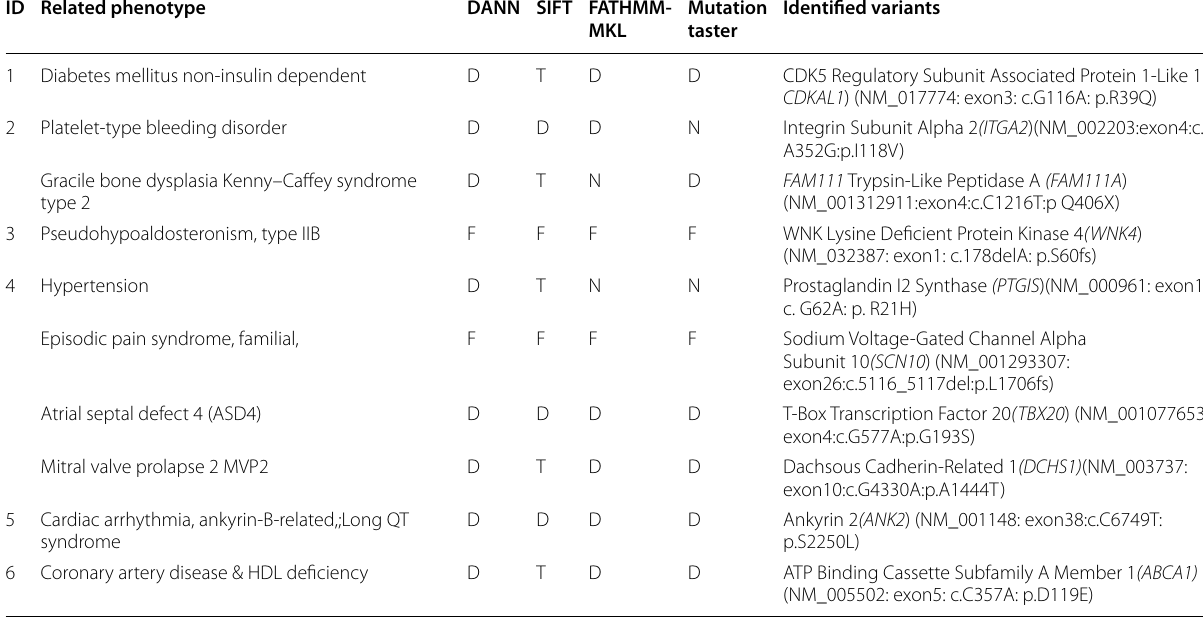
Table 1 Secondary findings in prediction software’s in clinical genomic whole-exome sequencing from families with